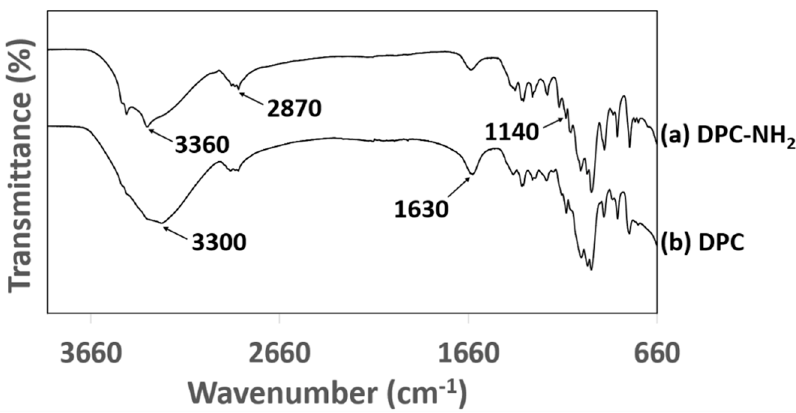
Figure 5. IR spectra of ( a ) DPC and ( b ) DPC-NH 2.